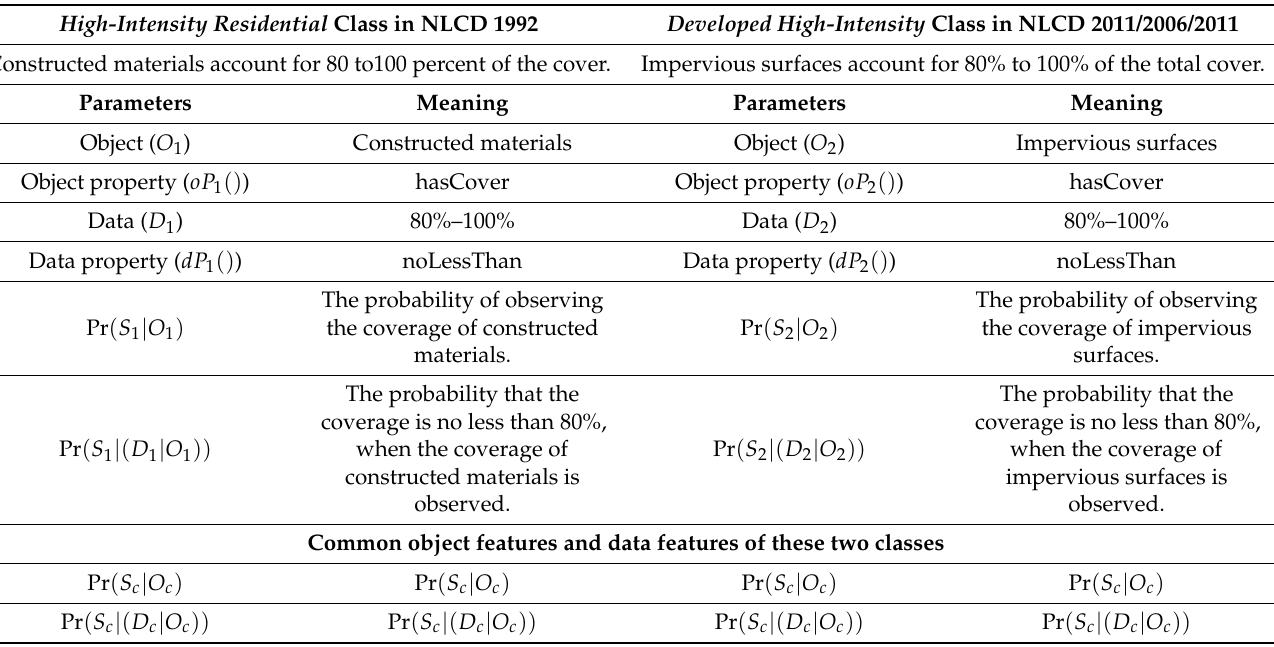
Table 3. Examples of semantic modeling for LULC classification systems and standards. High-Intensity Residential Class in NLCD